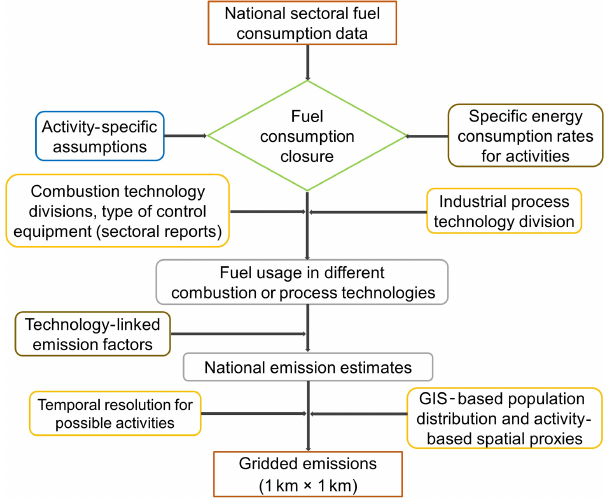
Figure 1. Methodology for energy and emission